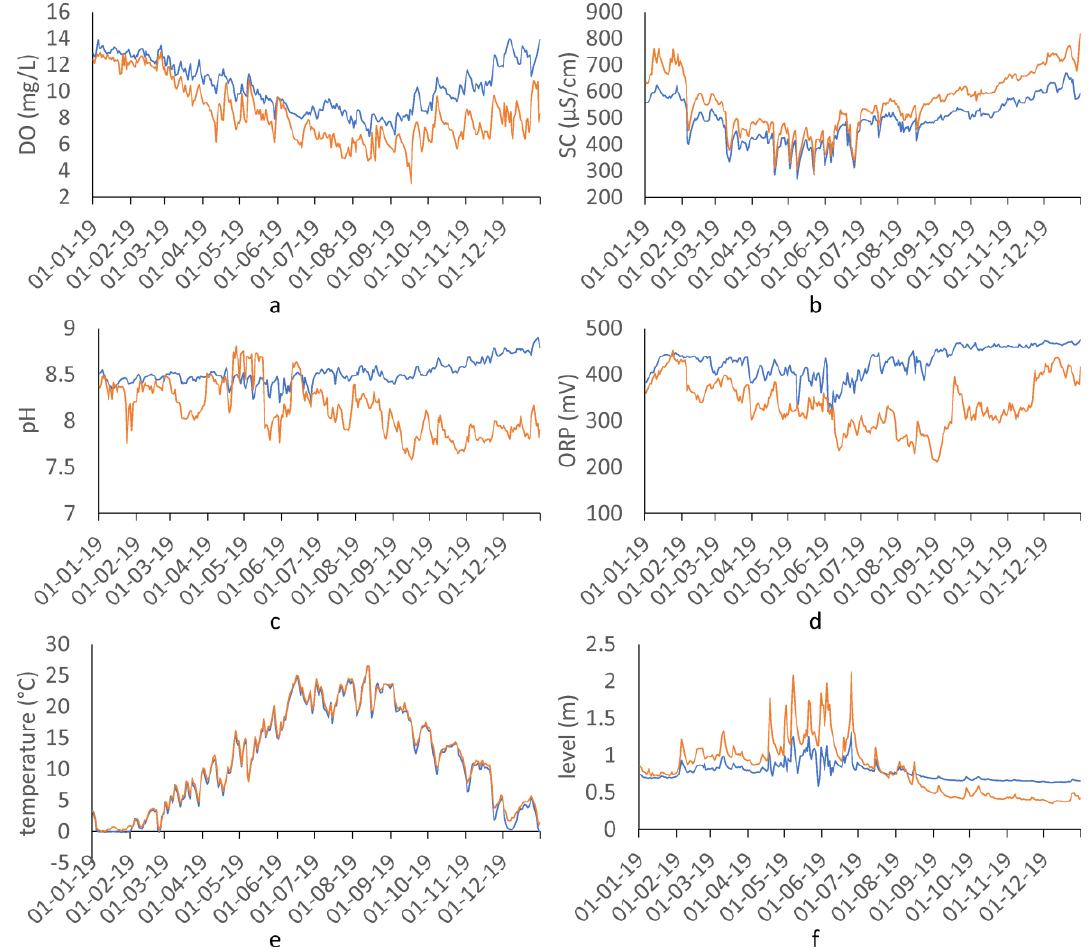
Figure 2. Comparative evolution of daily average values of the monitored parameters at Mihoveni (upstream, blue line) and Tişăuţi (downstream, orange line) in 2019: ( a ) dissolved oxygen (DO); ( b ) specific conductivity (SC); ( c ) pH; ( d ) oxidation reduction potential (ORP); ( e ) temperature; ( f ) level. The average hourly values of the water quality parameters at the upstream (Mihoveni) versus the downstream (Tişăuţi) monitoring points were: 10.39 mg/L vs. 8.38 mg/L DO, 491.89 µS/cm vs. 559.97 mg/L SC, 429.09 mV vs. 336.12 mV ORP, 8.52 vs. 8.13 pH, and 11.54 °C vs. 11.97 °C temperature.